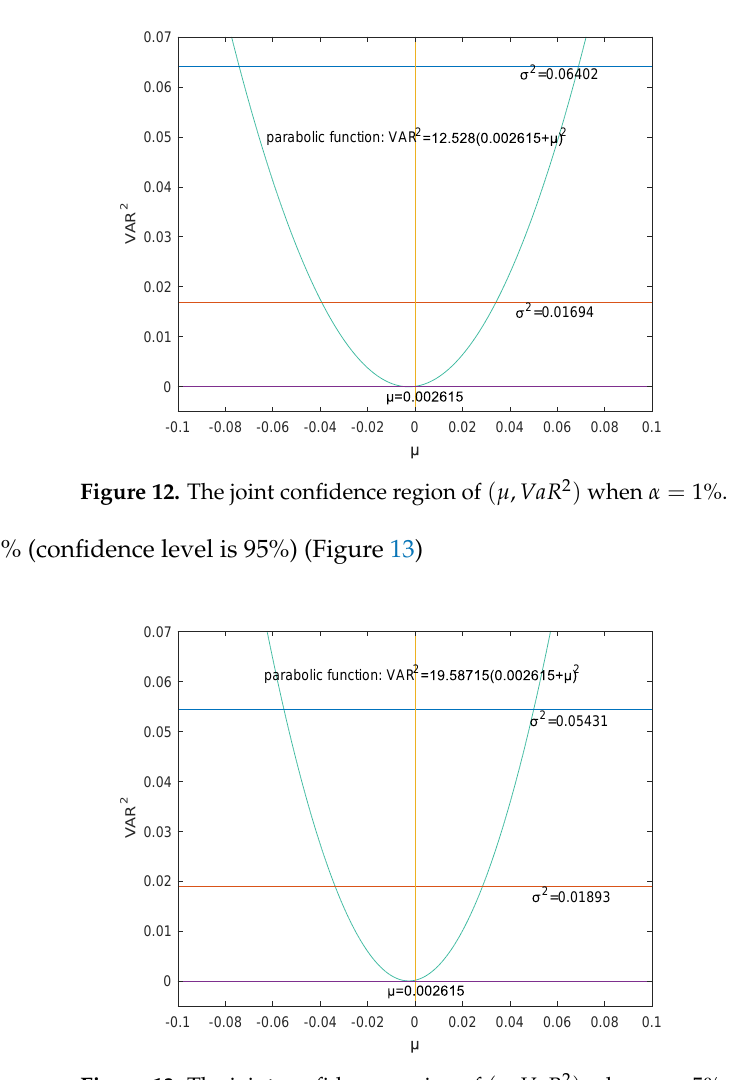
Figure 13. The joint confidence region of ( µ , VaR 2 ) when α = 5%.